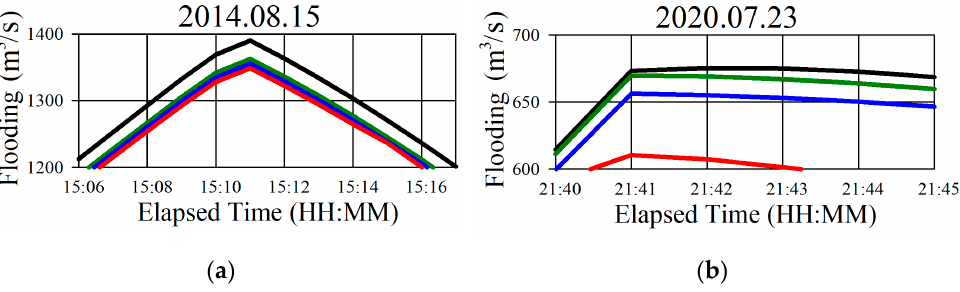
Figure 11. Flood reduction in the Suyeong River for various sizes of floodgate (actual rainfall). ( a )